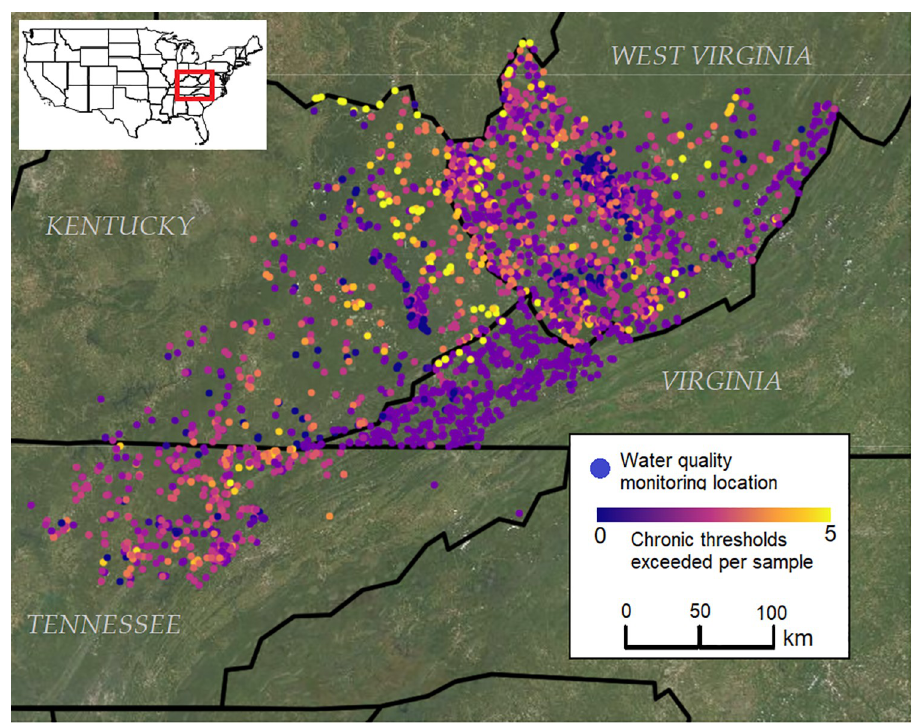
Fig 1. Chronic exposure thresholds for aquatic life were exceeded thousands of times in Central Appalachian waterways between 1985 and 2015. Map shows the locations of water quality monitoring stations within the study area encompassing parts of Kentucky, Tennessee, Virginia, and West Virginia shown on the inset map. Colors indicate the mean number of different water quality measures for which chronic exposure thresholds were exceeded each time a sample was taken at a given location. The basemap contains USGS/NASA Landsat data from 2020, accessed through Google Earth